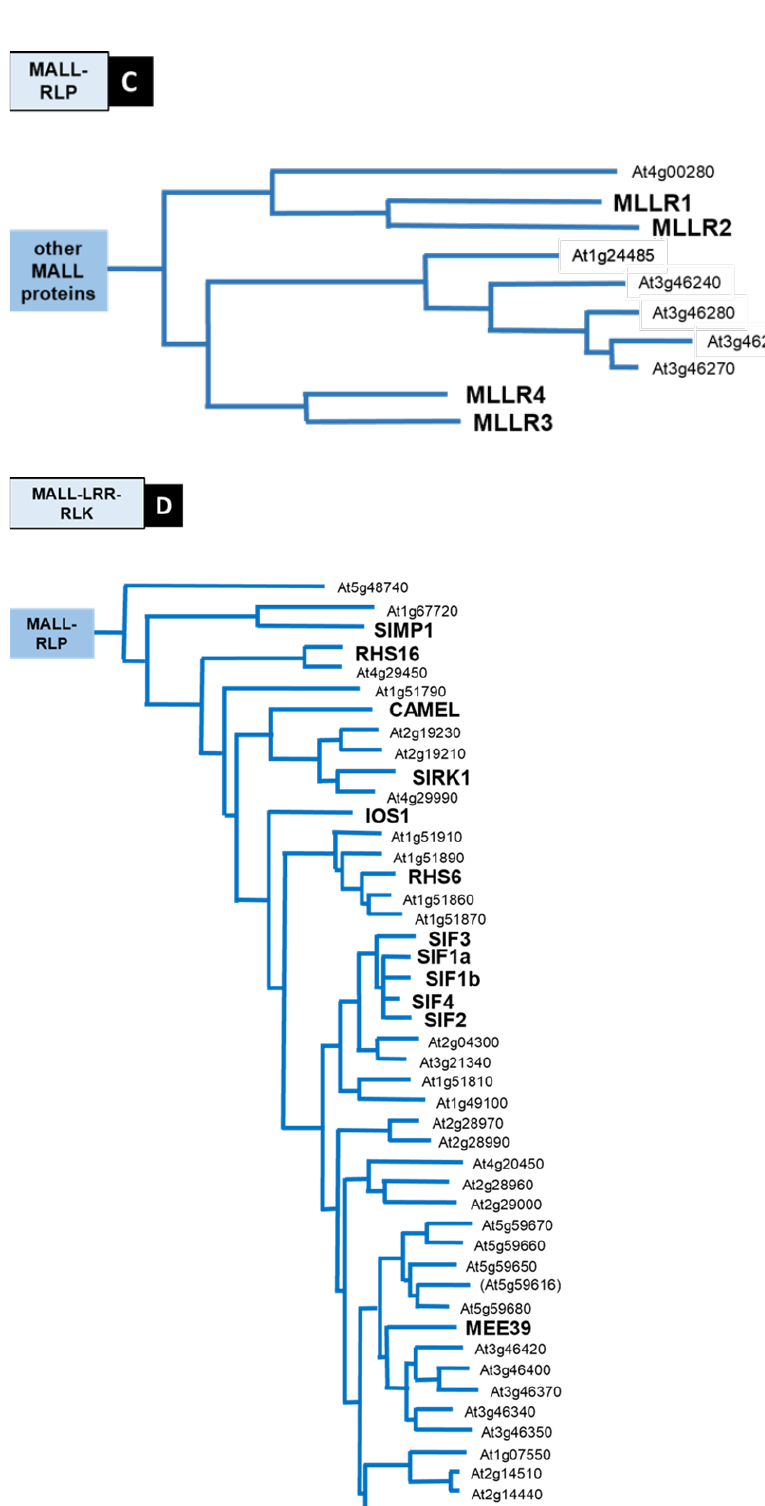
Figure 1. Phylogenetic tree of MAL- and MALL-proteins. The tree shows one branch with MAL domain (PF11721)-containing proteins (red, A ) and three branches with the distantly related MALL do- main (PF12819)-containing proteins (blue, B – D ). For details, cf. Yang et al. [134]: ( A ) LRR-MAL-RLKs; ( B ) MALL-RLKs; ( C ): MALL-RLPs; ( D ) MALL-LRR-RLKs. Protein (and abbreviations) described in the literature are in bold (and discussed in the text). For the others, the Arabidopsis protein numbers are given. For details, cf. TAIR-homepage